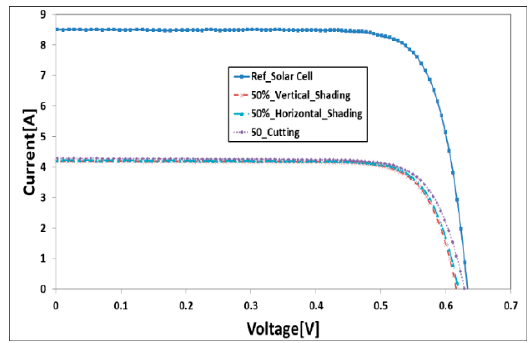
Figure 7. Current-voltage characteristic curve with 50% cut and shading.